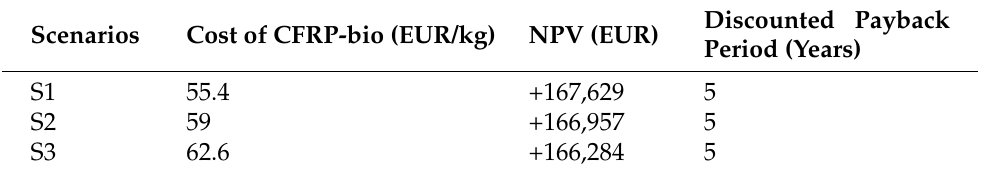
Table 18. Result of the economic assessment of the repair business of producer/remanufacturer for product made from CFRP-bio based on various ranges of material